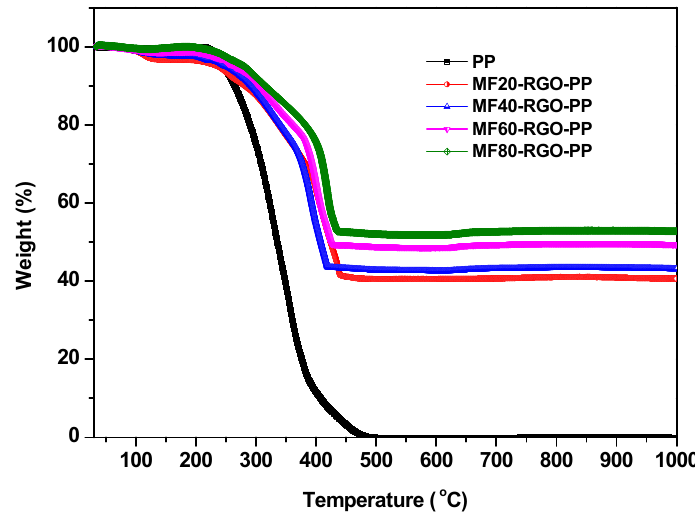
Figure 9. TGA curves of polypropylene (PP) and its prepared MF20-RGO-PP, MF40-RGO-PP, MF60-RGO-PP and MF80-RGO-PP nanocomposites under air